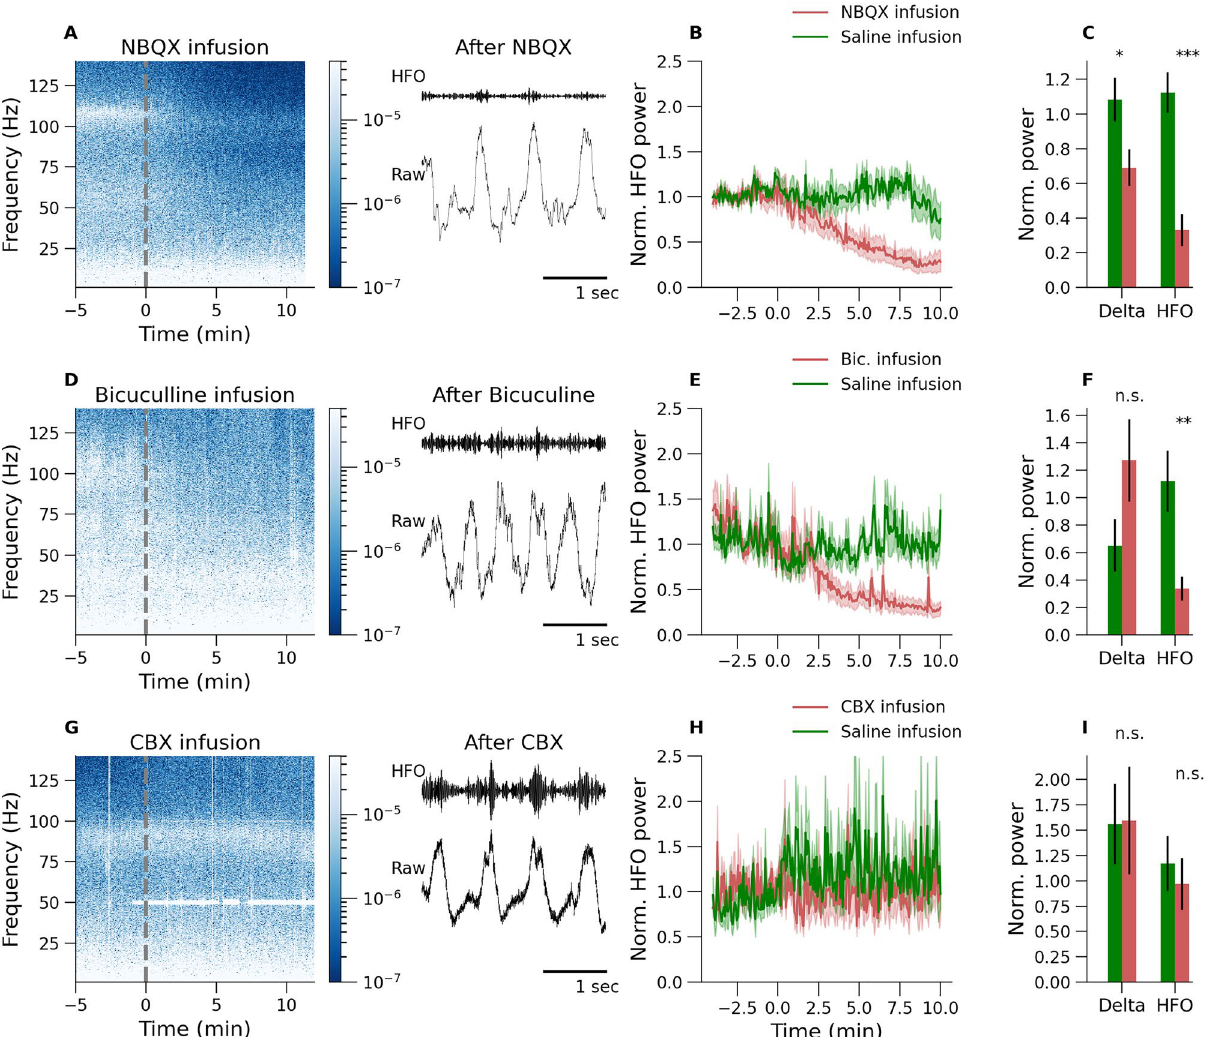
Figure 4. KX-dependent 80–130 Hz activity is AMPA dependent ( A – C ) and GABA-A dependent ( D – F ) but independent of gap junctions ( G – I ). Drugs were infused to unilaterally, and saline infused on the opposite side. Examples of the time courses (dotted line indicates the moment of infusion) and short 3 s data epochs of the raw and 80–130 Hz band pass-filtered waveforms are shown. ( A – C ) shows results for NBQX local infusion to the OB which caused a significant reduction in power of the 80–130 Hz oscillations and a smaller but significant effect for delta ( C , n = 7). GABA-A receptor blockade with bicuculline infusion also reduced 80–130 Hz power without significantly affecting delta power ( D – F , n = 5). Gap junction blockage with carbenoxolone had no significant effect on the 80–130 Hz rhythm, nor delta power ( G – I , n = 4). (*p<0.05, **p<0.01, ***p<0.001 and n.s. (not significant) with respect to saline